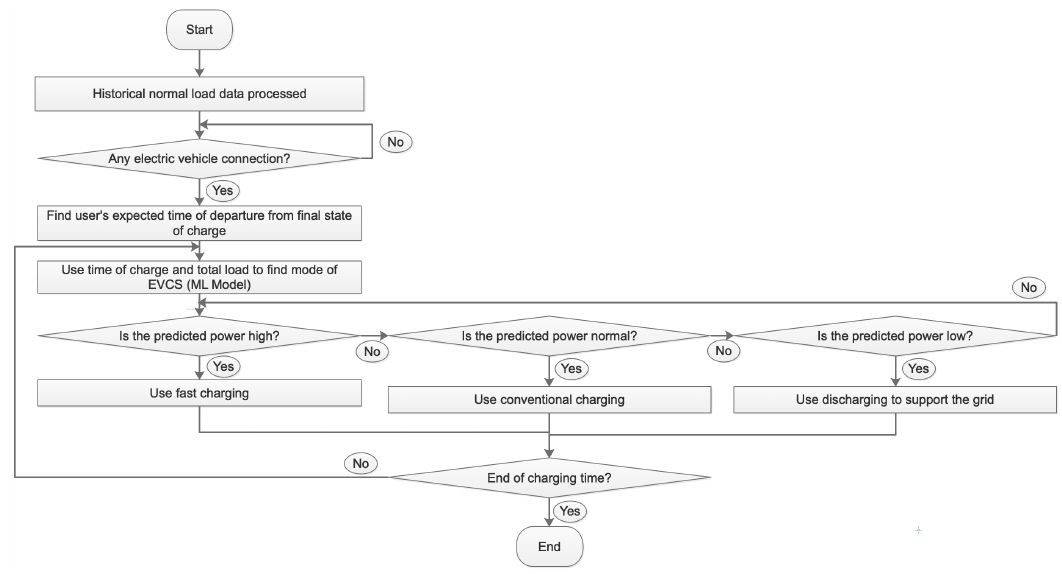
Figure 3. Sequence diagram of the operation of ML